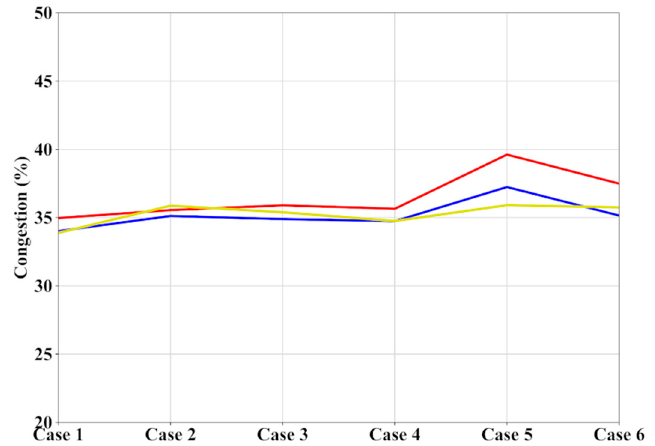
Figure 12. Optimal congestion thresholds for cluster center 2 considering favorable inclination angles of 75° (in red), 70° (in blue), and 65° (in yellow).